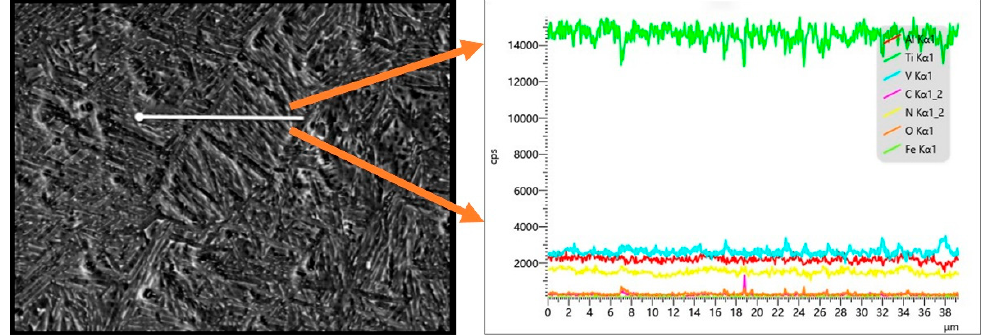
Figure 12. Energy dispersion spectrum (EDS) line scan analysis of the sample with a line offset of 0.28 mm.